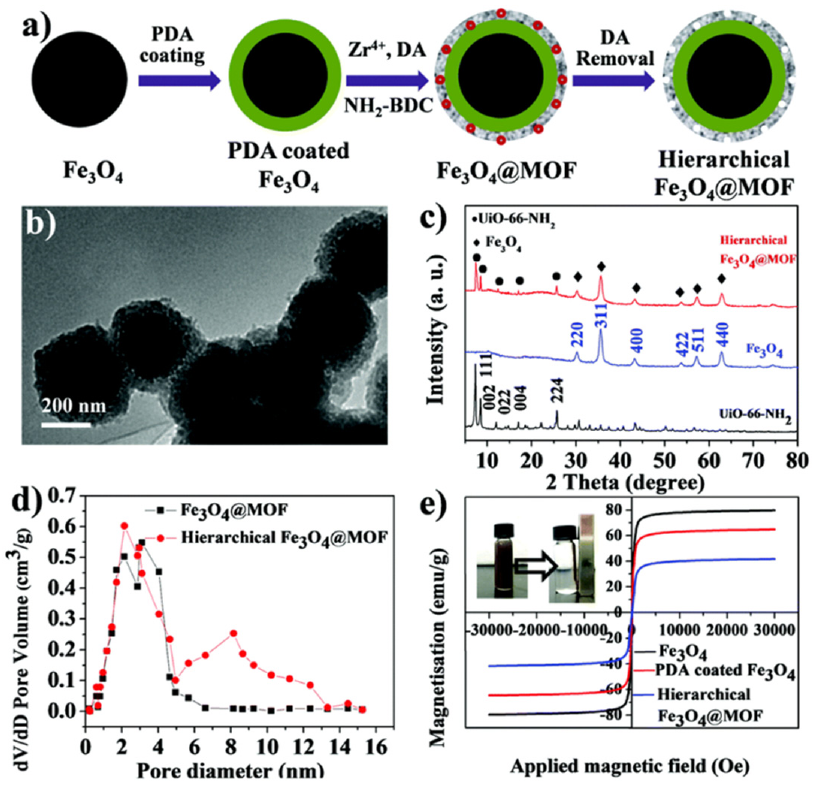
Figure 7. Synthesis and characterization of the magnetic hierarchically porous MOF (hierarchical F 3 O 4 @MOF). ( a ) Schematic illustration for the three-step preparation; ( b ) TEM image of the hierar- chical F 3 O 4 @MOF; ( c ) XRD profiles of UiO-66-NH 2 (MOF, bottom), F 3 O 4 (middle), and hierarchical F 3 O 4 @MOF (top); ( d ) pore size distribution curves of F 3 O 4 @MOF (black) and hierarchical F 3 O 4 @MOF (red); and ( e ) magnetic hysteresis loops of F 3 O 4 , PDA coated F 3 O 4 and hierarchical F 3 O 4 @MOF, inset is the photographs of the magnetic responsiveness. Reproduced with permission from [63], the Royal Society of Chemistry,